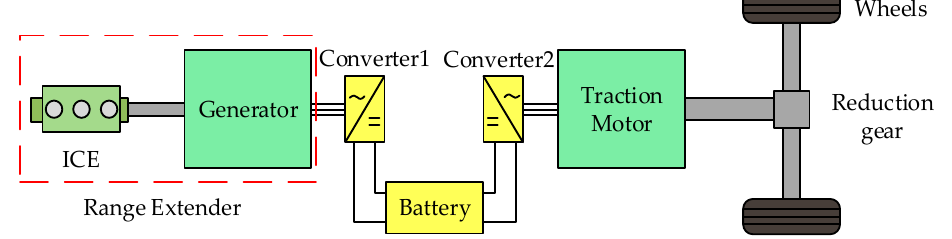
Figure 1. Structure diagram of the powertrain system of EREVs.